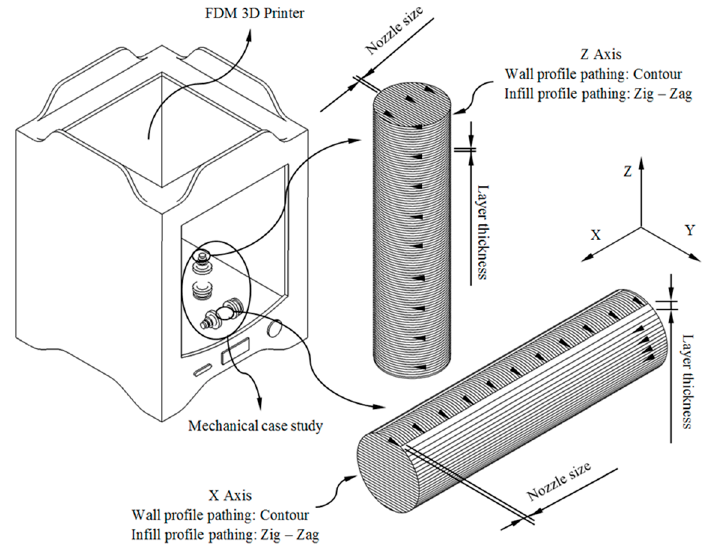
Figure 3. FDM (fused deposition modeling) process configuration for the manufacture of the end part.